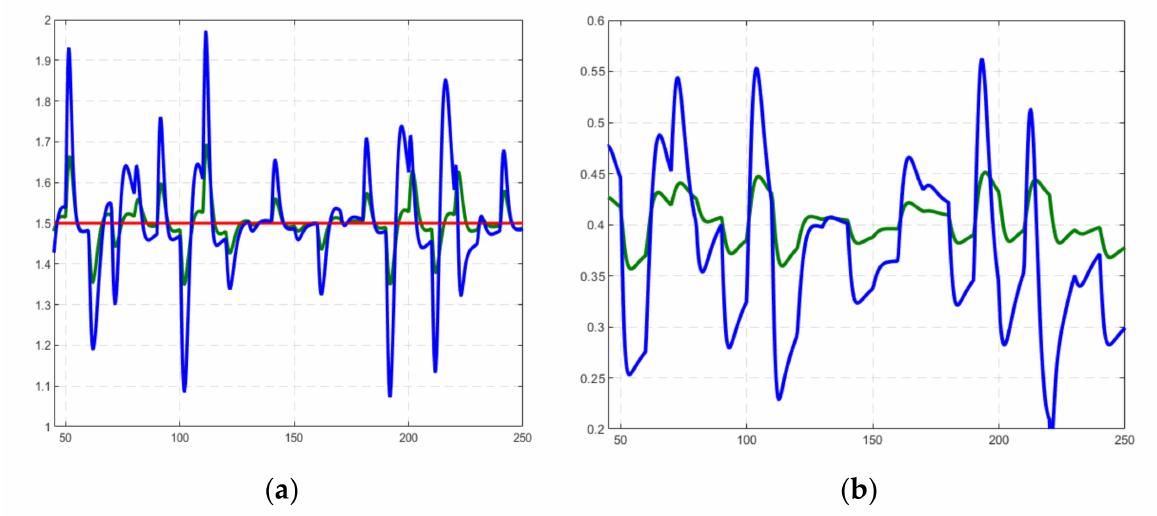
Figure 20. ( a ) Evolution of the controlled variable, and ( b ) the command variable for (cid:101) ω = 3.5 [ rad/d ] . The respective variable from the reference situation is represented with a green line (see Figures 16 and